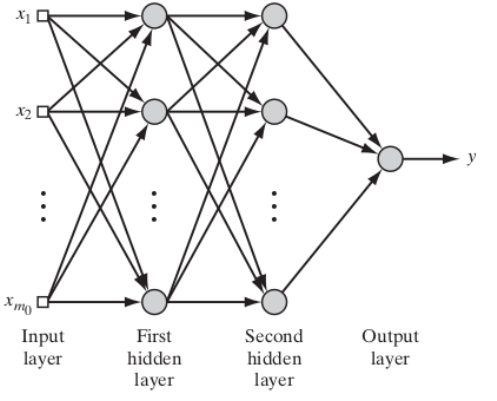
Figure 3. MLP architecture. Source: